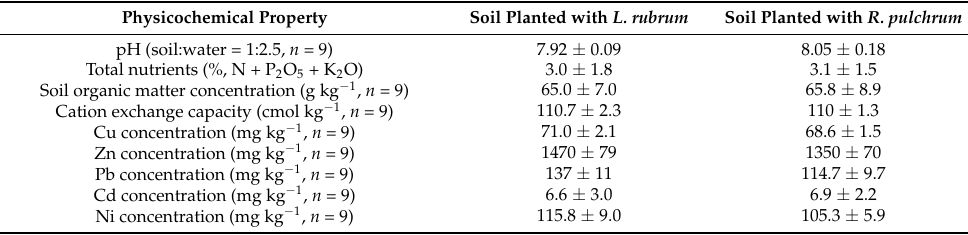
Table 1. The physical and chemical properties of the artificial soil made of sewage sludge. Physicochemical Property Soil Planted with L. rubrum Soil Planted with R. pulchrum pH (soil:water = 1:2.5, n = 9)